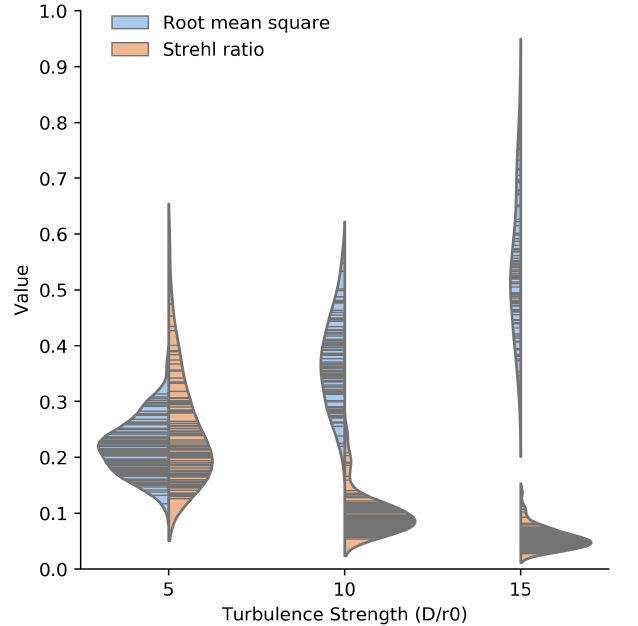
Figure 2. Statistics of the simulated phase screens. The root mean square (RMS) error and the Strehl ratio are depicted in a violin plot. The left side of the pattern for each turbulence strength indicates RMS distribution. The right side of each pattern indicates the Strehl ratio distribution. The two types of distribution share the same unit of measurement. Every stick denotes a simulated phase screen, the RMS or Strehl ratio of which is indicated by the stick’s